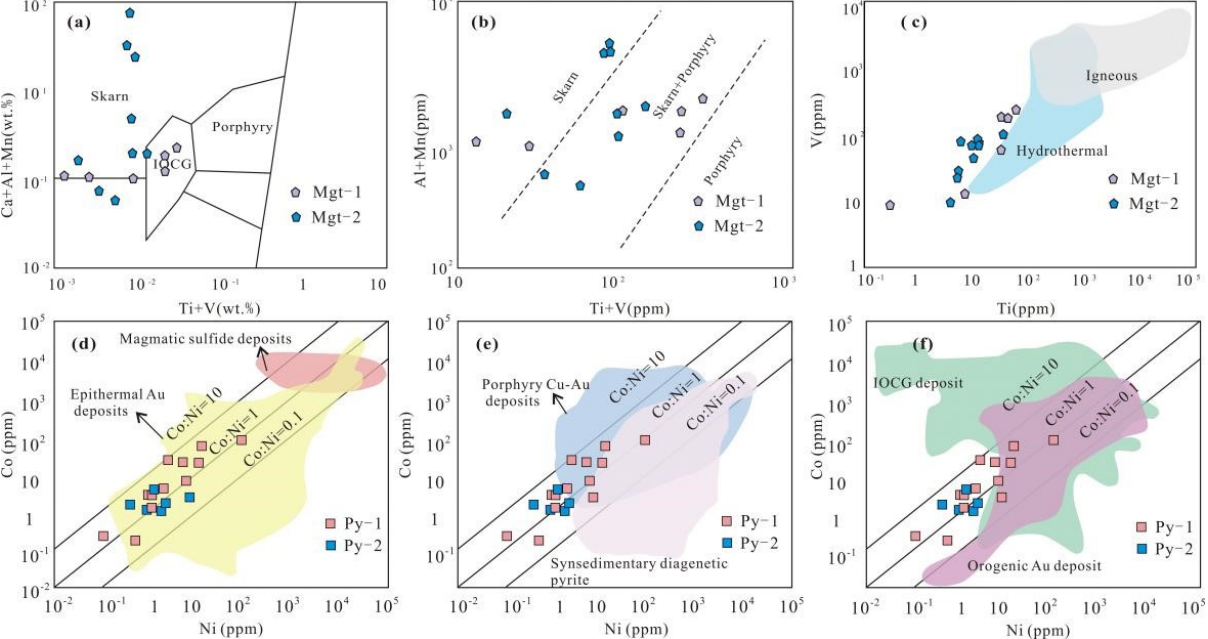
Figure 8. Genetic discrimination diagram for the magnetite and pyrite from Dongping deposit: ( a ) Ca + Al + Mn vs. Ti + V diagram for the magnetite; ( b ) Ni/(Cr + Mn) vs. Ti + V diagram for the magnetite [32]; ( c ) V vs. Ti for the magnetite [33,34]; ( d – f ) Co vs. Ni diagram for the pyrite [37]. The data used in the figure are from Tables 2 and